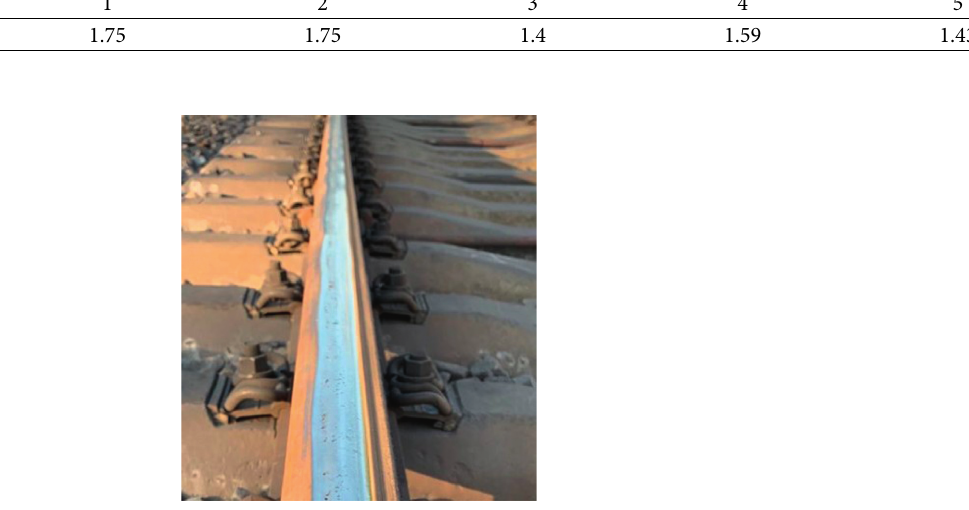
Figure 12: The surface condition of the rail for the mileage section K199